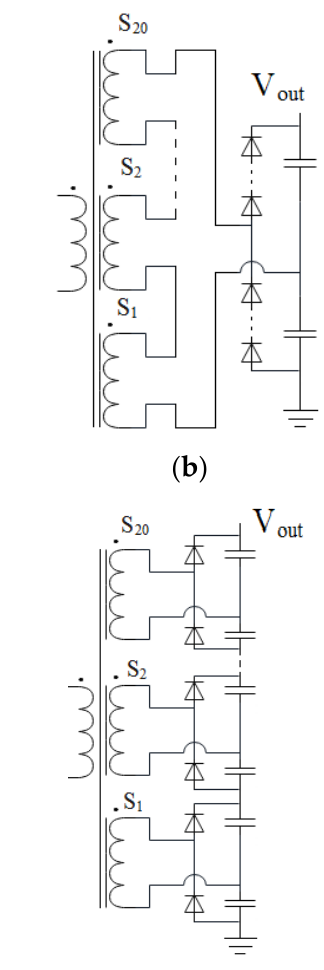
Table 1. Transformer prototype parameters.